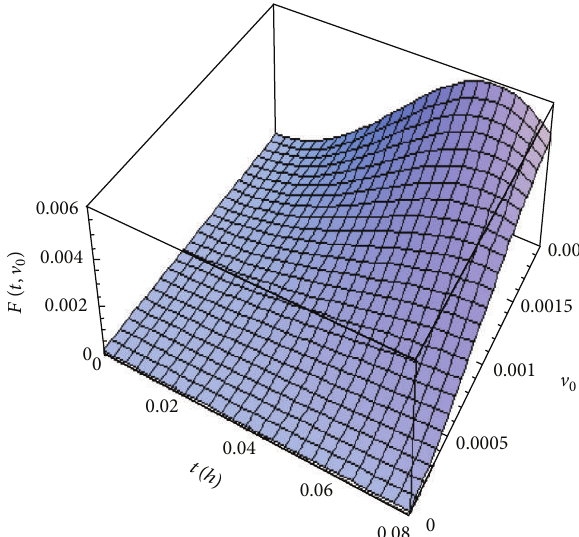
Figure 3: Approximate solution of the contact force in the elastic indentation phase (27) with 𝛽 = 1.9 .